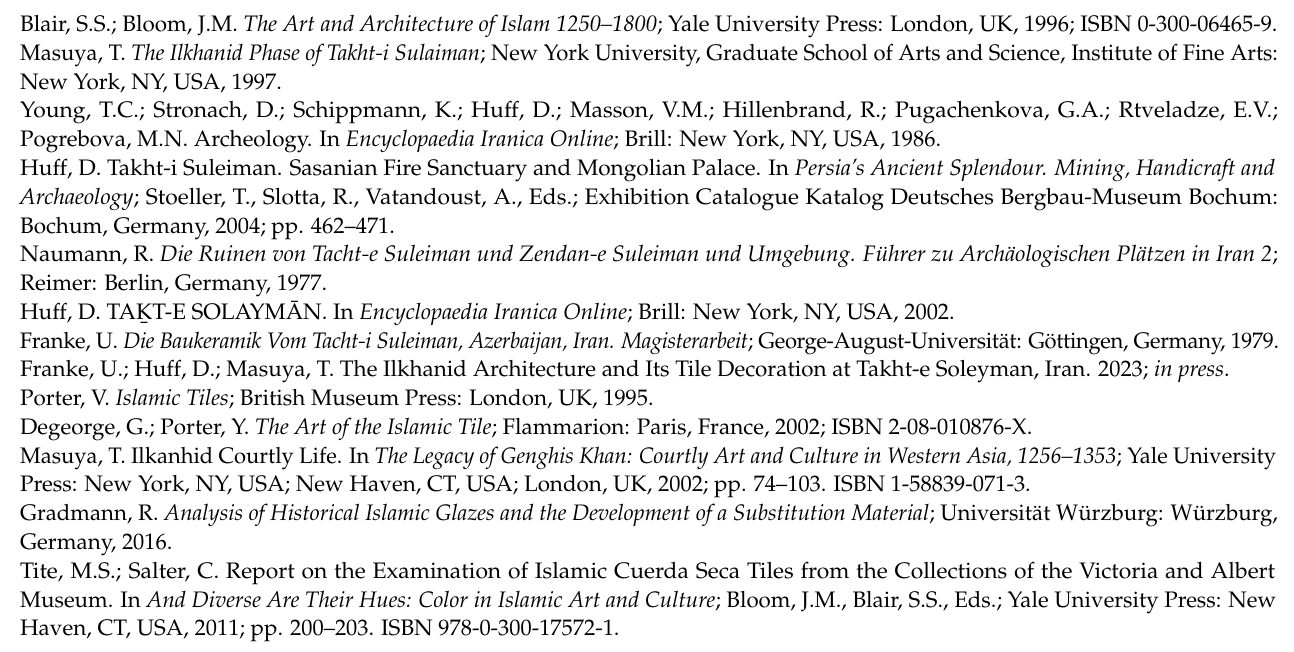
Table S5: Composition in oxide wt% for the glazes of samples ISL7 (M21). Table S6: analysis of the ceramic body by SEM/EDX given in wt%. Table S7: analysis of the glazes by SEM/EDX given in wt%, summarized by colour and ceramic paste. Figure S1: SEM picture of the turquoise glaze of sample